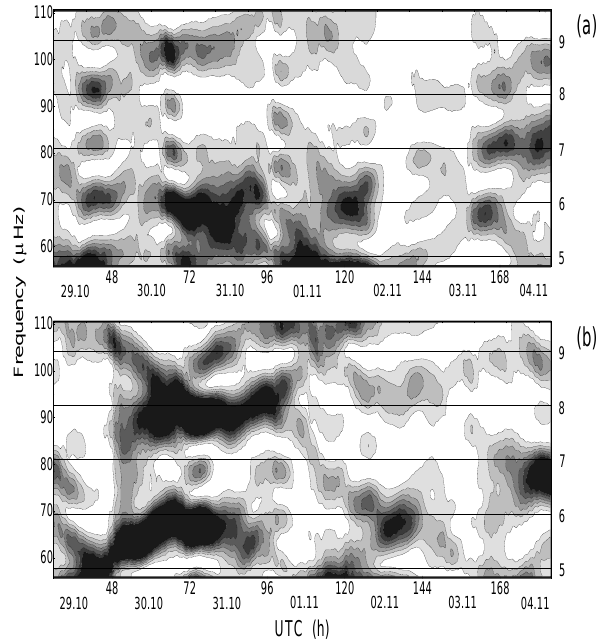
Fig. 3. Fig. 3. Temporal behavior of power frequency spectra (in arbitrary units) in the 42–90min period range, derived from microbarome- ter (a) and seismometer (b) measurements during 21–25 September 1997. Blacking indicates spectral intensity more than one third of the maximum magnitude, contour interval is 1/18 of this magnitude. The time is counted from the beginning of the record. The horizon- tal lines correspond to the frequencies of solar tide subharmonics. The numbers at these lines indicate subharmonic numbers.